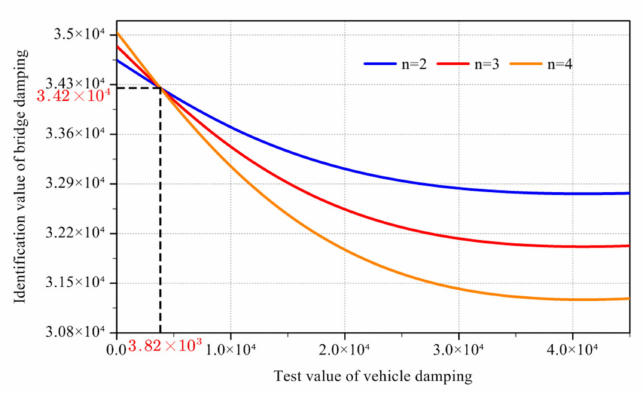
Figure 11. Identification curves of bridge damping coefficients.